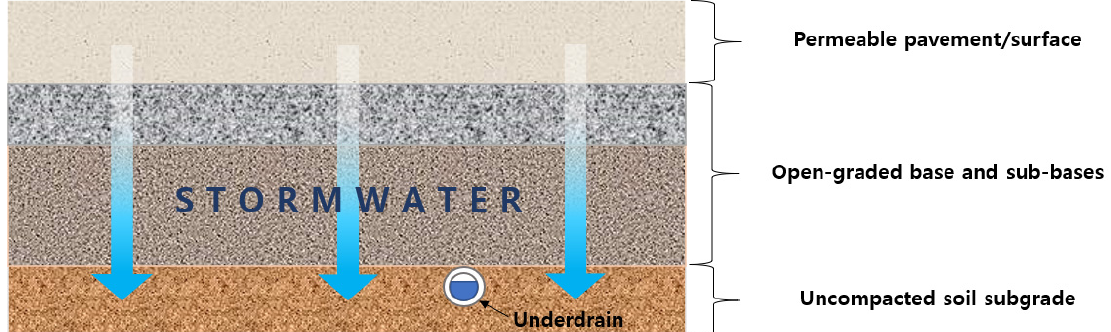
Figure 1. Permeable pavements.